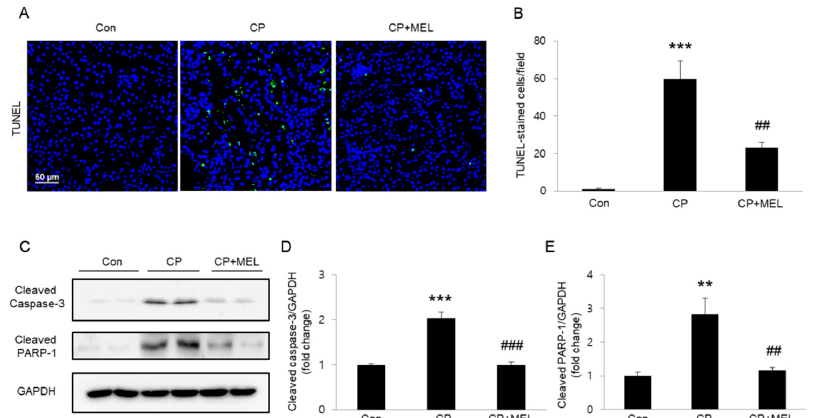
Figure 4. Effects of melatonin (MEL) on apoptotic cell death in kidneys of mice treated with cisplatin (CP). ( A ) Representative images of TdT-mediated dUTP nick end labeling (TUNEL) staining. Scale bar: 50 µ m. ( B ) Number of TUNEL-positive cells. ( C ) Western blots of cleaved caspase-3 and cleaved poly(ADP-ribose) polymerase 1 (PARP-1) levels in kidneys. ( D ) Quantification of cleaved